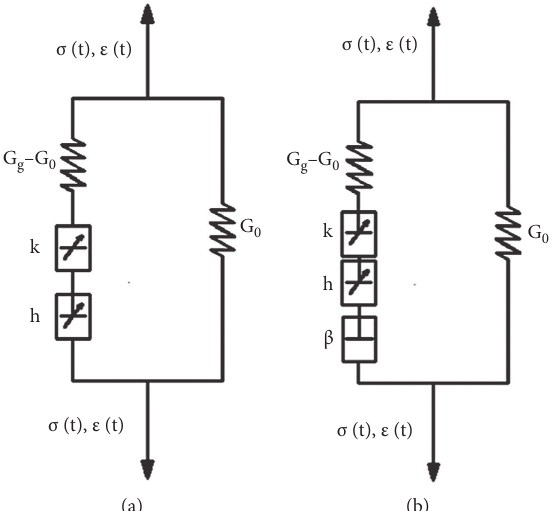
Figure 24: Huet–Sayegh model (a) and 2S2P1D model (b) [139].